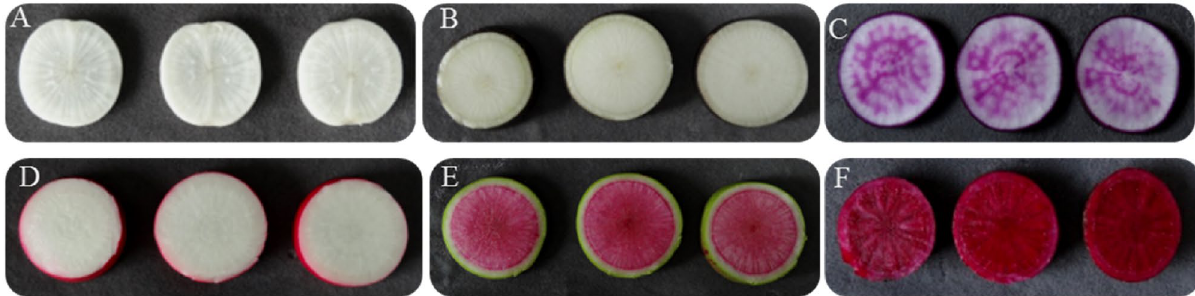
Figure 1. Taproot colors of the six radish accessions: ( A ) Shizhuangbai (SZB) has white taproot skin (WS) and white flesh (WF); ( B ) black radish has black taproot skin (BS) and white flesh (WF); ( C ) Zijinling (ZJL) has purple taproot skin (ZJLS) and purple flesh (ZJLF); ( D ) Manshenhong (MSH) has light red taproot skin (PS) and white flesh (WF); ( E ) Xinlimei has green taproot skin (XLMS) and red flesh (XLMF); ( F ) Touxinhong (TXH) has dark red taproot skin (RS) and dark red flesh